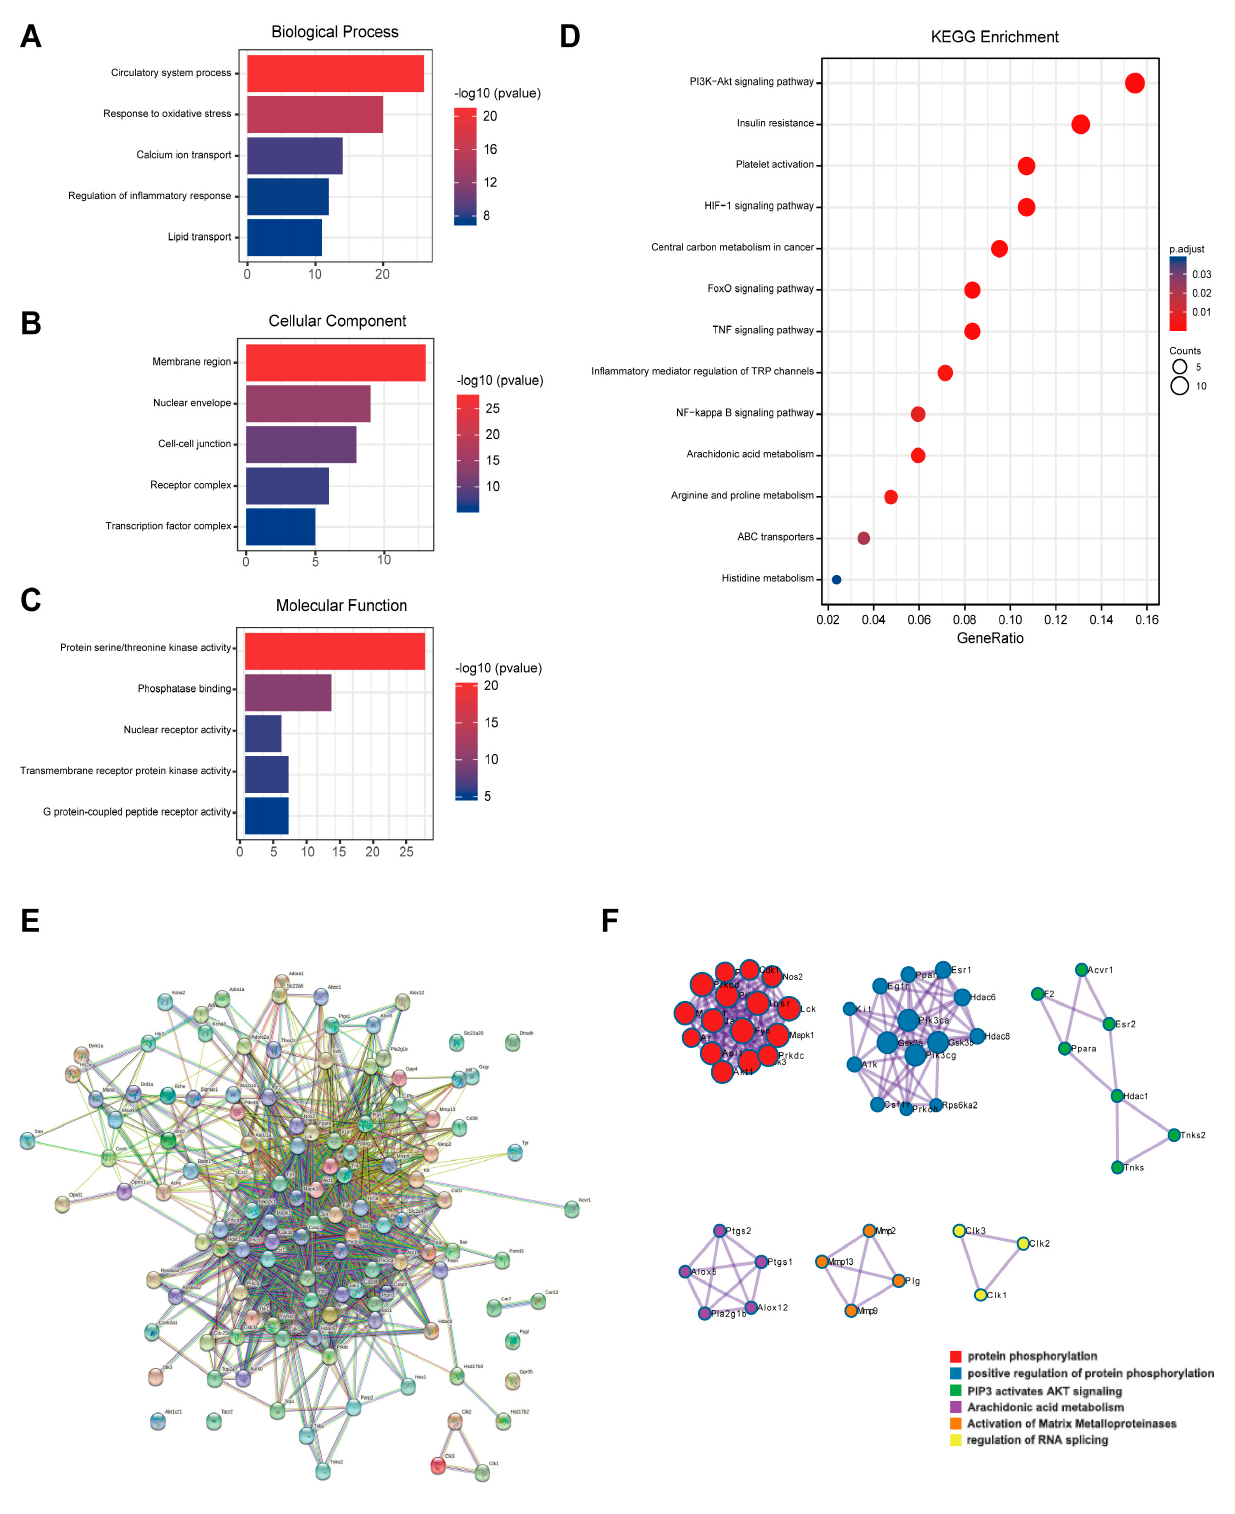
Figure 5. Results of network pharmacological analysis. ( A ) Biological process of GO analysis; ( B ) cellular component of GO analysis; ( C ) molecular function of GO analysis; ( D ) KEGG pathway enrichment; ( E ) network diagram of PPI analysis; and ( F ) results of MCODE analysis.